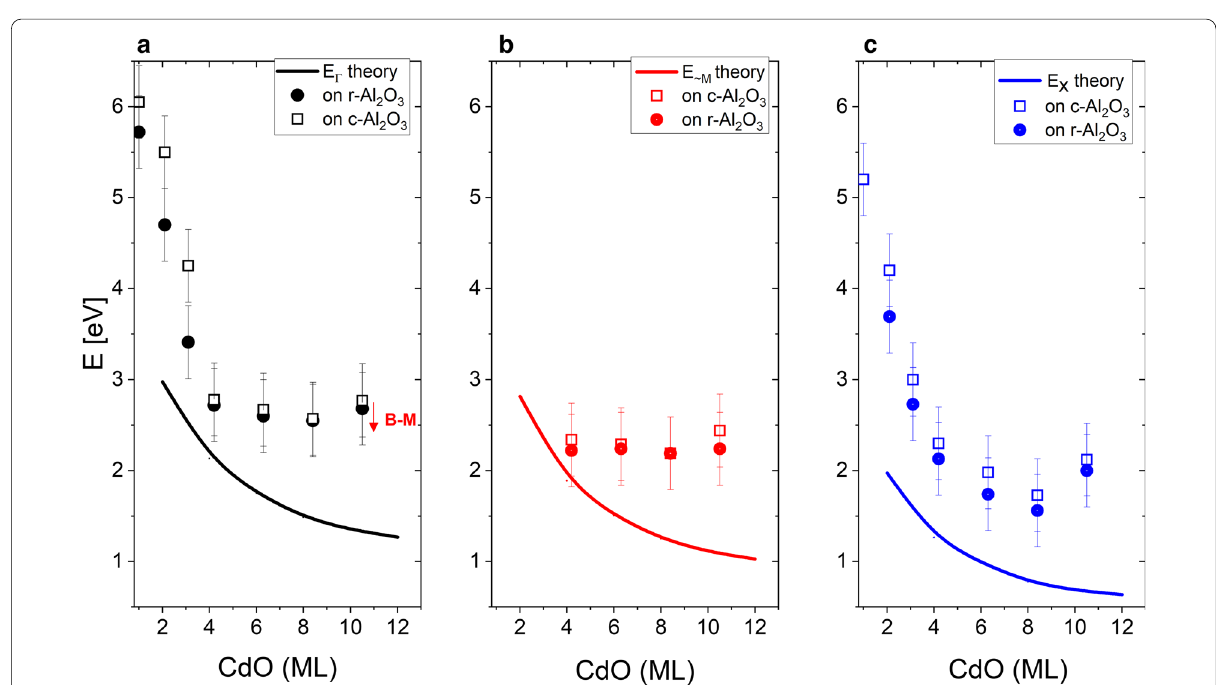
Fig. 8 Comparison of the theoretical band gaps (solid lines) in Γ, X points and one maximum located close to M point and experimental data (symbols) obtained from transmittance data